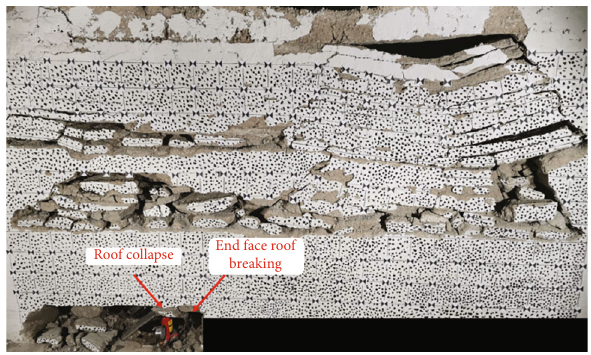
Figure 12: Distribution characteristics of cracks before end face roof